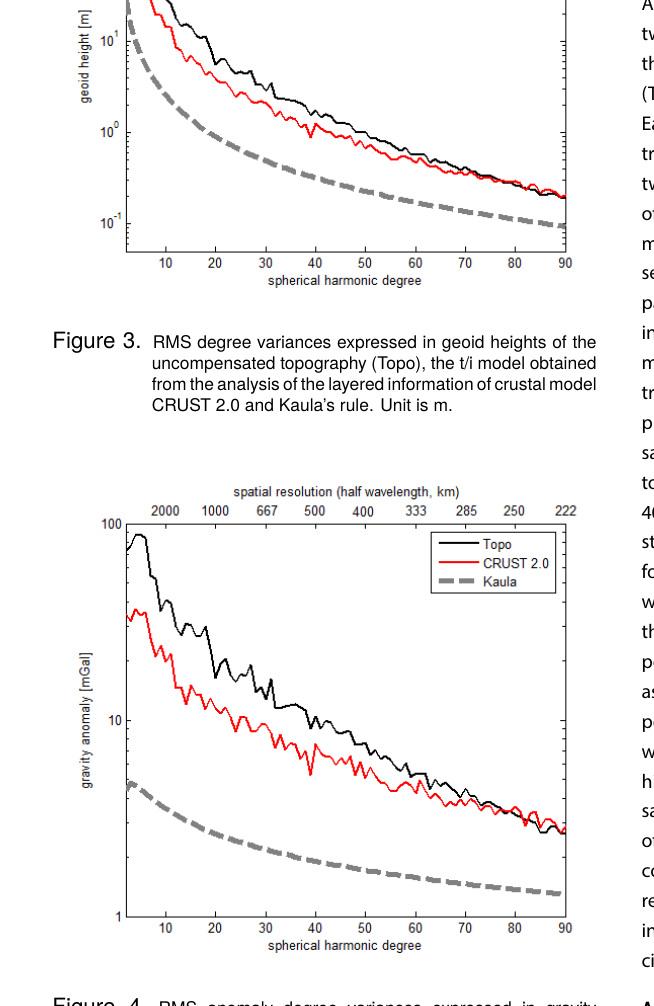
Figure 4. RMS anomaly degree variances expressed in gravity anomalies of the uncompensated topography (Topo), the t/i model obtained from the analysis of the layered informa- tion of crustal model CRUST 2.0 and Kaula’s rule. Unit is